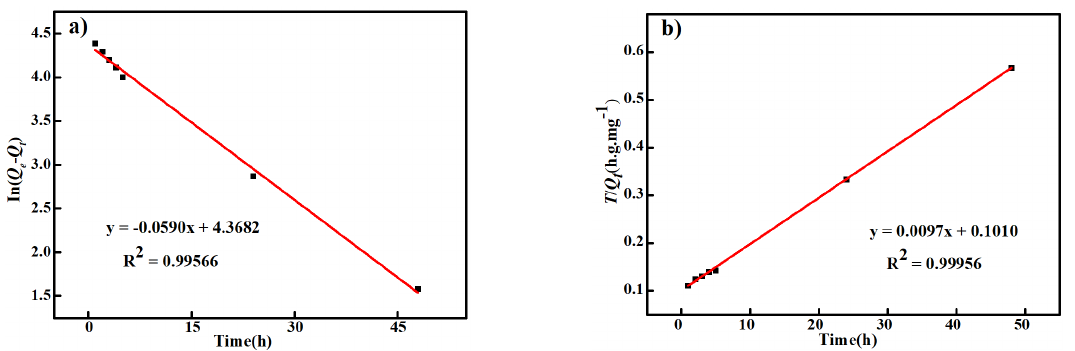
Figure 11. Linear fitting curves of pseudo first − order ( a ) and second − order ( b ) adsorption kinetic models of the carbonized ZIF − 8@PAN nanofiber membrane.